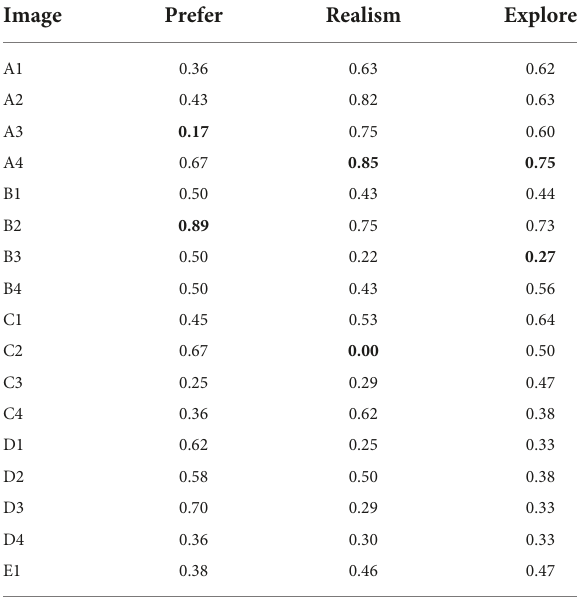
TABLE 1 Fraction of times each image was selected out of the total number of times it was shown. Image Prefer Realism